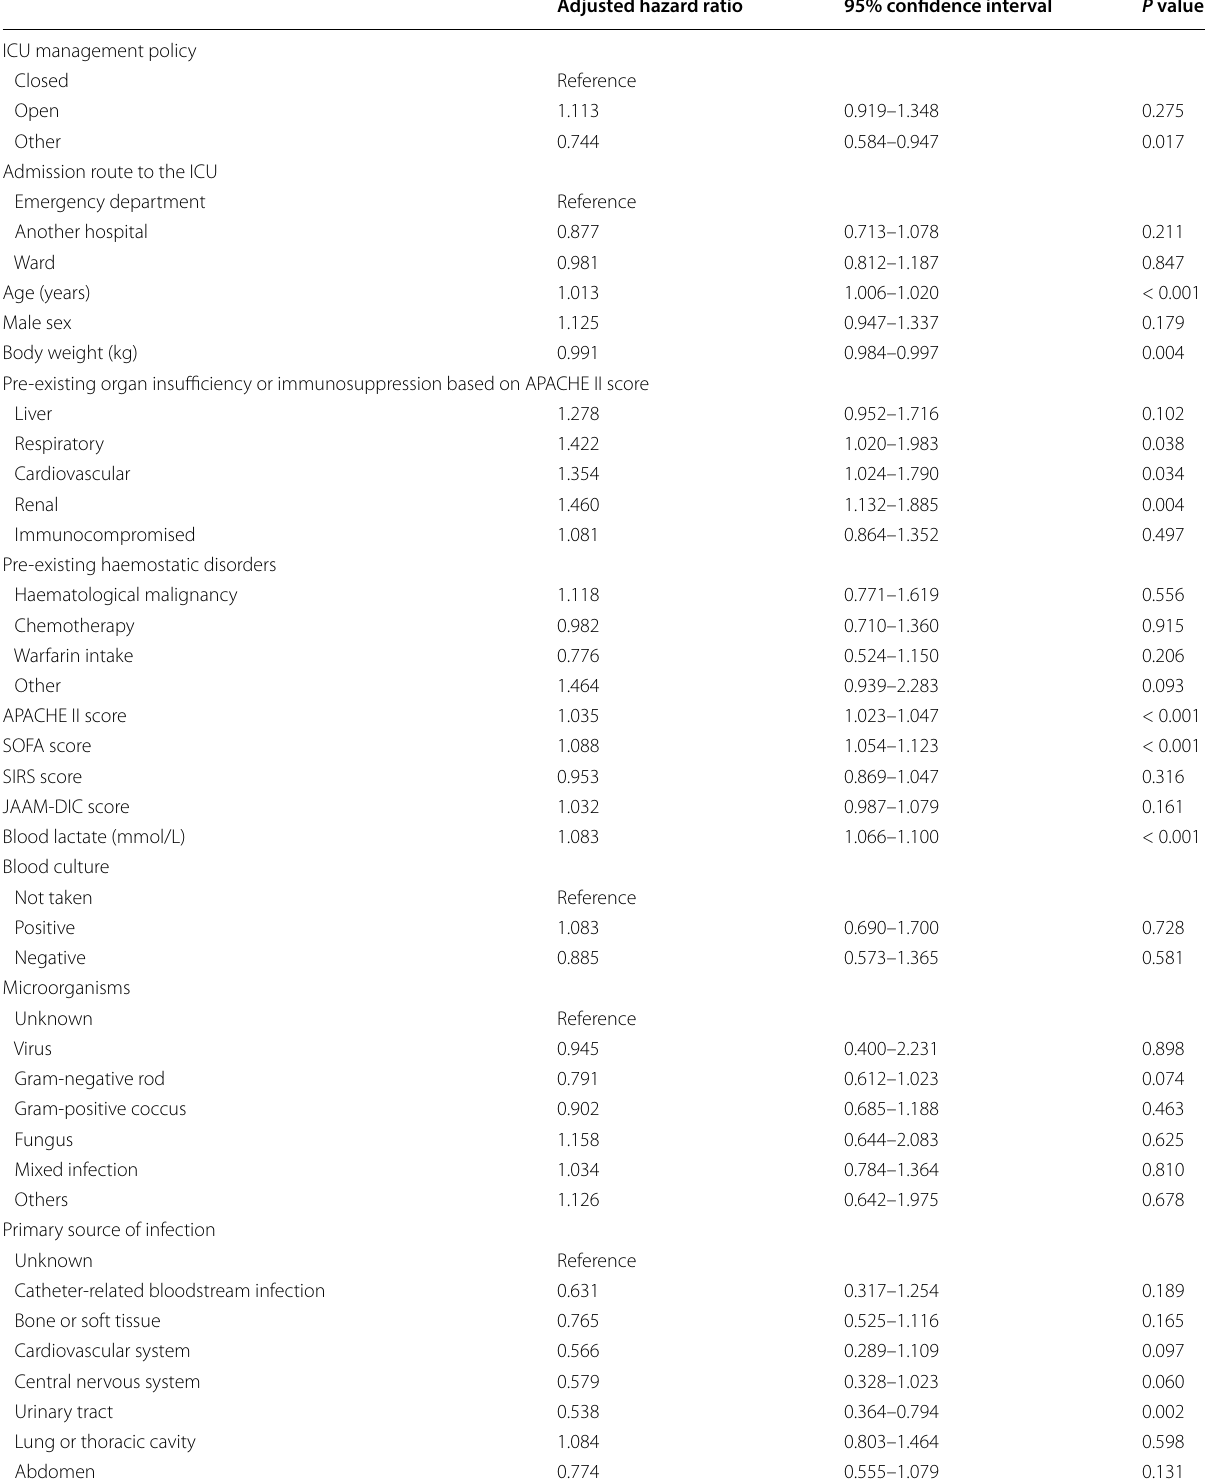
Table 2 Cox regression model adjusted for patient characteristics and therapeutic variables for hospital